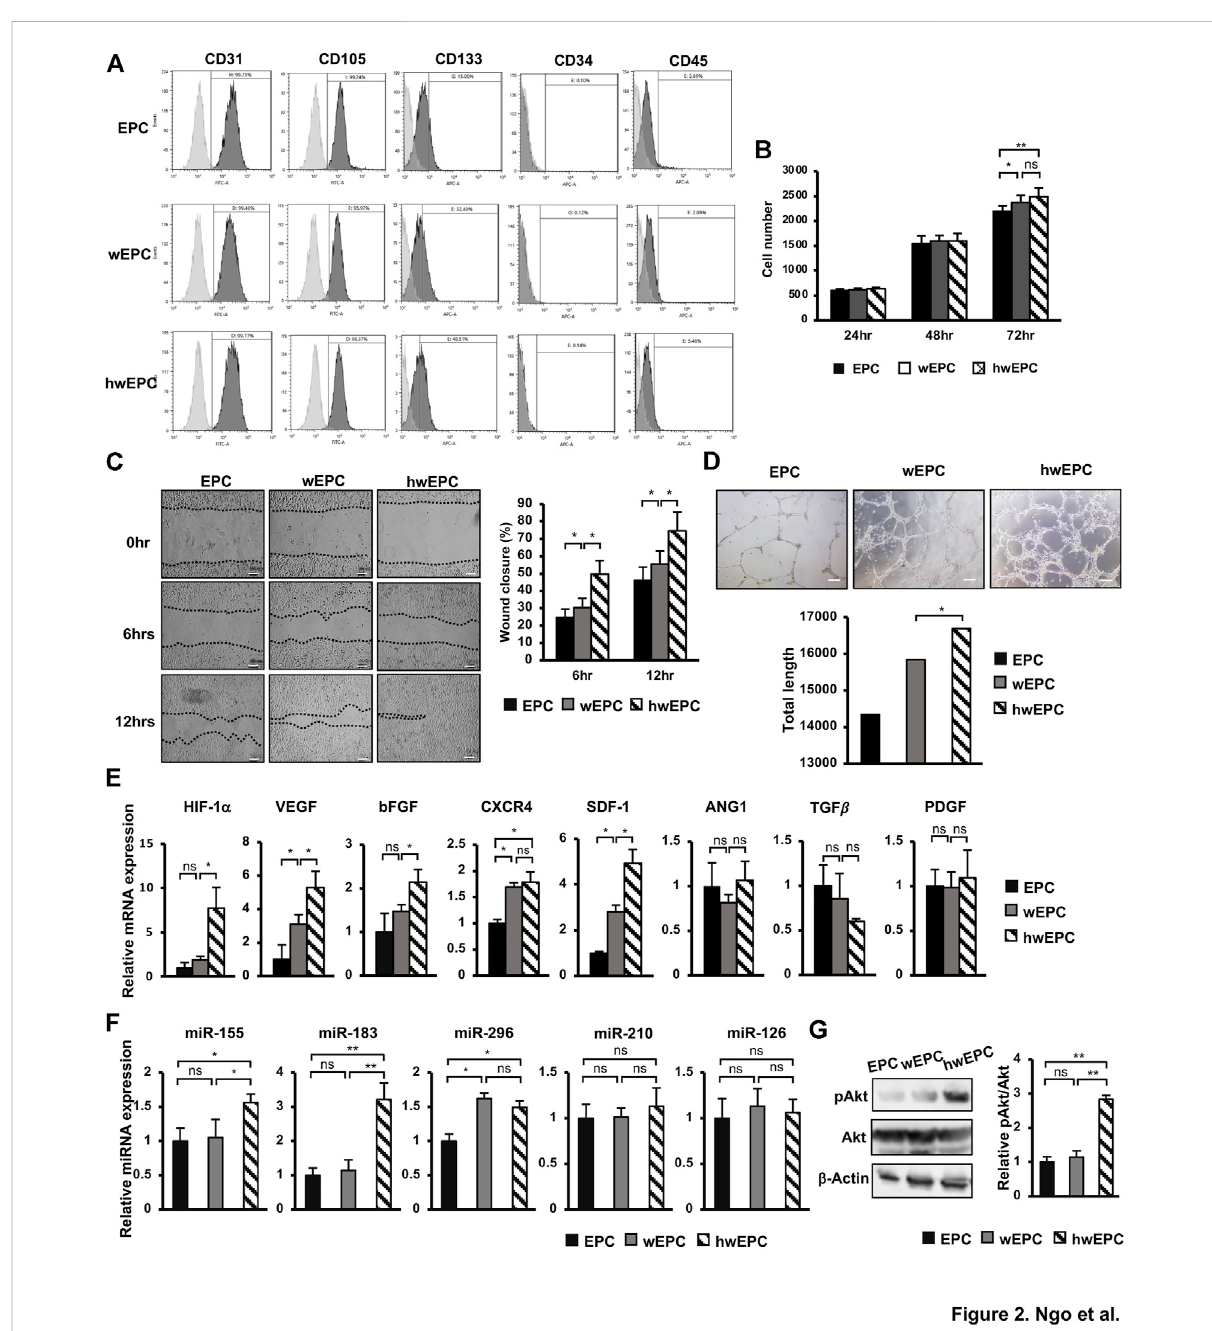
FIGURE 2 hwEPCshowedsigni fi cantlyinducedproliferation,migration,andangiogenicabilities,incomparisontoEPCandEPC (A) .Markers ’ expressionof EPC was examined by fl ow cytometry (B) . The cell proliferation of EPC (C) . Migration assay of EPC. Photos were captured under a microscope at 4 × magni fi cation. Bars indicate 100 µm (D) . Representative imaging and total length of EPC tube formation. Photos were captured under a microscope at4×magni fi cation.Barsindicate200 µm (E) .ThegeneexpressionofEPC (F) .ThemiRNAsexpressionofEPC,normalizedwithRNU48 (G) .The phosphorylation of Akt in EPC was examined by Western Blotting. Full-length Western blots are shown in Supplementary Figure S6. The data represent the mean ± SD. ** p < 0.01, * p < 0.05, ns: no signi fi cance. N = 3. The experiments were performed in